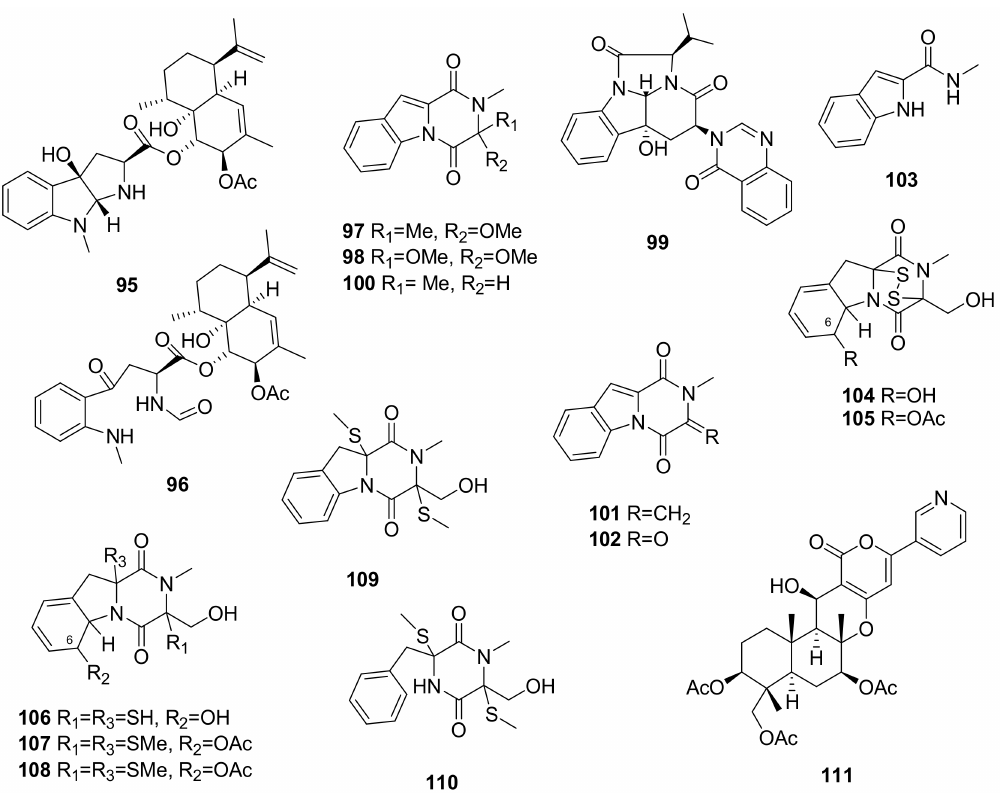
were evaluated for their antibacterial activity against